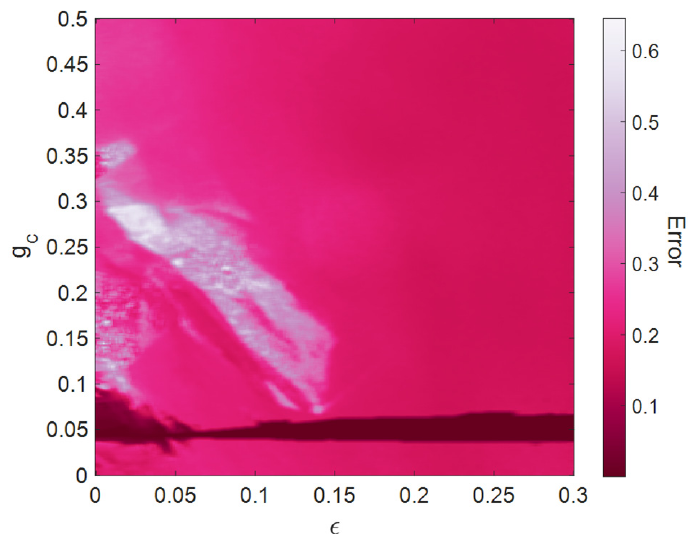
Figure 5. Synchronization error of the ring network of 100 memristive maps connected through both chemical and electrical synaptic couplings by the variation of coupling strengths. The network parameters are Θ s = − 40, β = 50, and v ∗ s = − 40. Complete synchronization can be observed for a small range of chemical coupling strength.